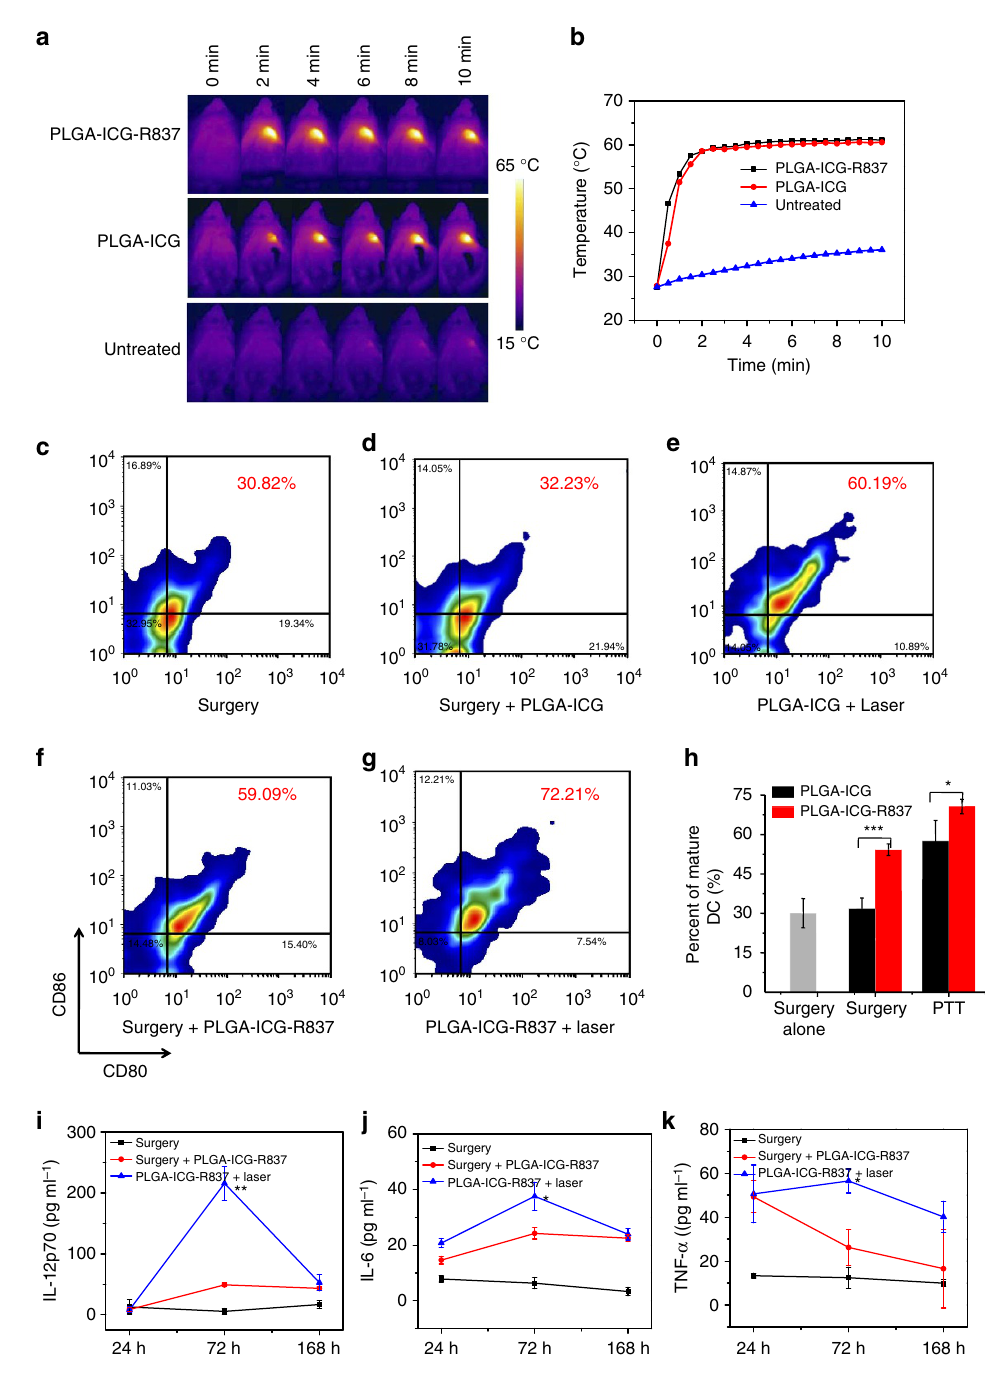
Figure 2 | Immune responses after PLGA-ICG-R837-based PTT. ( a ) IR thermal images of 4T1-tumour-bearing mice injected with PLGA-ICG-R837, PLGA-ICG or PBS under the 808nm laser (0.5Wcm (cid:2) 2 ) irradiation. ( b ) The tumour temperature changes based on IR thermal imaging date in a . ( c – h ) DC maturation induced by PLGA-ICG-R837-based PTTon mice-bearing 4T1 tumours (gated on CD11c þ DC cells). Cells in the tumour-draining lymph nodes were collected 72h after various treatments for assessment by flow cytometry after staining with CD11c, CD80 and CD86. ( i – k ) Cytokine levels in sera from mice isolated at 24, 72 and 168h post different treatments (surgery, surgery and s.c. injection of PLGA-ICG-R837, i.t. injection of PLGA-ICG-R837 and PTT). Three mice were measured in each group in ( a – k ). Data are presented as the mean ± s.e.m. P values were calculated by Tukey’s post-hoc test (*** P o 0.001, ** P o 0.01 or * P o 0.05). For ( i – k ), P values were determined between the second group (Surgery þ PLGA-ICG-R837) and the third group (PLGA-ICG-R837 þ